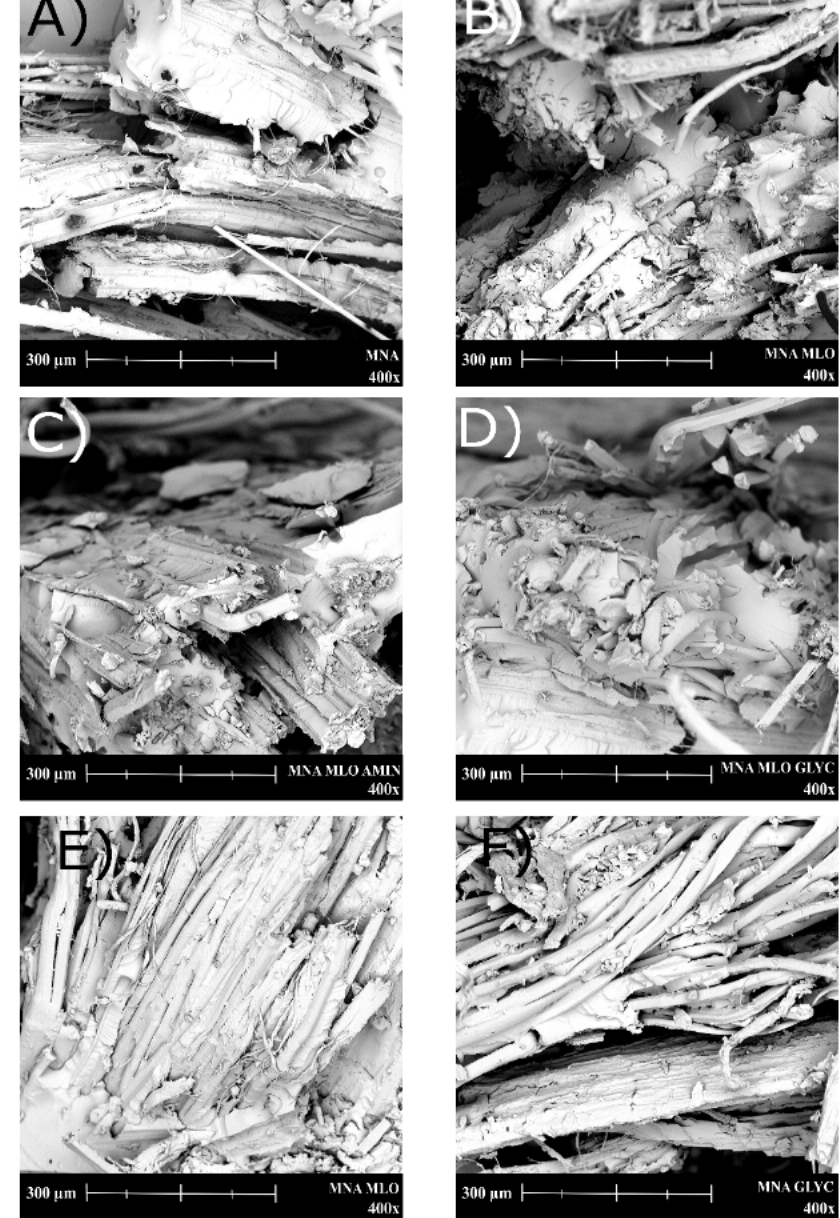
Figure 8. SEM micrographs (400×) of the fracture surfaces of composites based on ELO epoxy resin cross-linked with MNA/MLO mixture and flax fabric reinforcement with different surface treatments, ( A ) MNA, ( B ) MNA:MLO, ( C ) MNA:MLO:AMIN, ( D ) MNA:MLO:GLYC, ( E ) MNA:MLO:MAL, ( F ) MNA:GLYC.